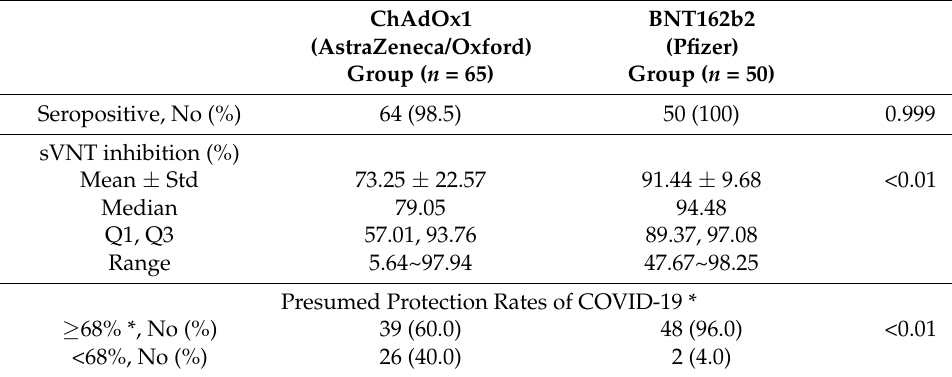
Table 2. Serology results after 2nd dose of vaccine.